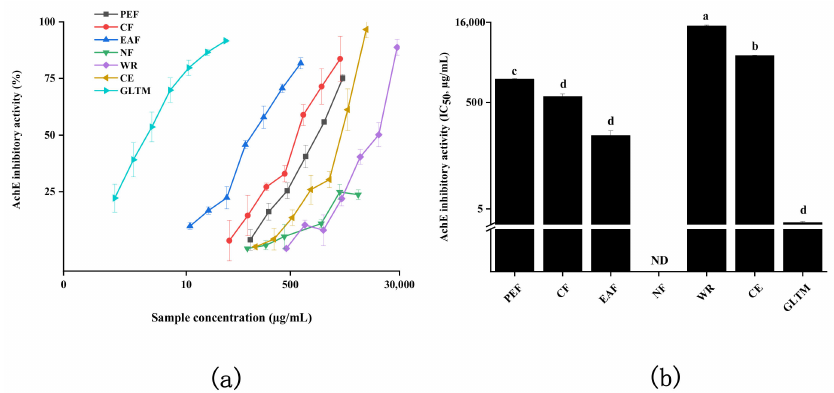
Figure 6. AChE inhibition of bioactive fractions from quinoa. ( a ) The inhibition rate of the AChE with different concentrations. ( b ) The IC 50 values of different samples toward AChE inhibitory activity. The different letters in the column represented significantly difference ( p < 0.05).